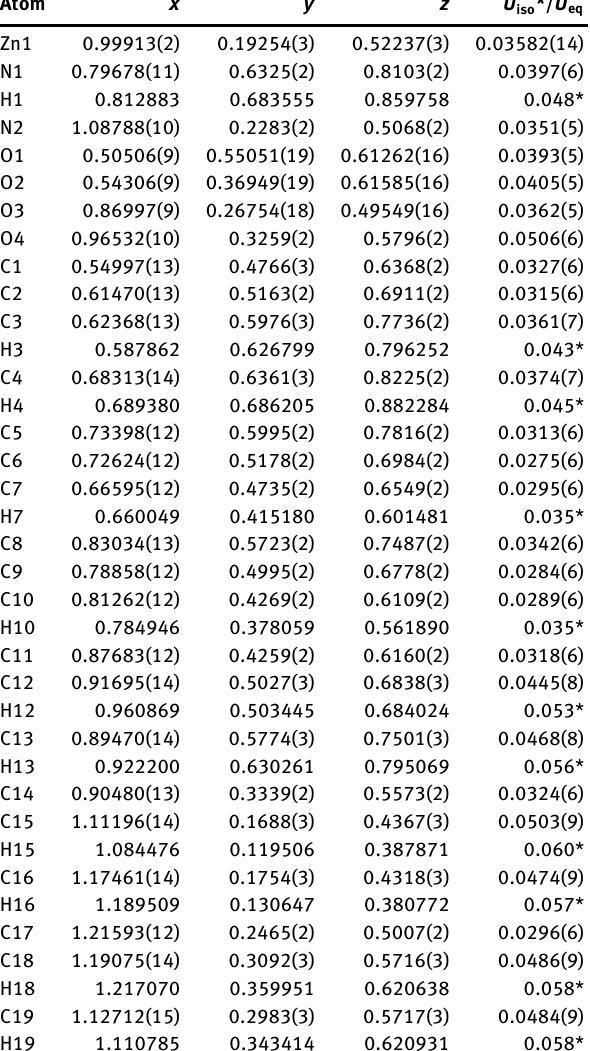
Table 2: Fractional atomic coordinates and isotropic or equivalent isotropic displacement parameters (Å 2